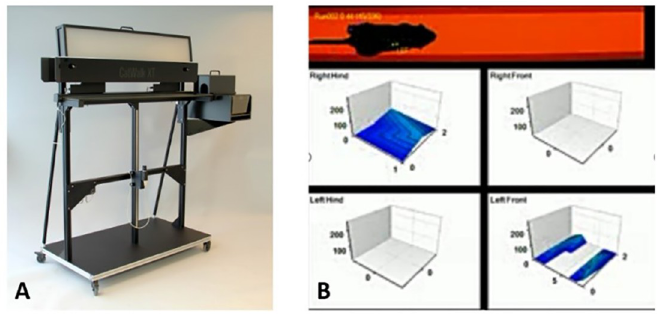
Fig 1. Overview of the CatWalkXT 1 automated gait analysis system. The hood is elevated to obtain a better overall impression of the walkway. For gait analysis, the hood is closed creating a tunnel guiding the animals direction of movement (A, image provided Noldus Information Technology, Wageningen, The Netherlands). Fruthermore, an example of automated CatWalkXT 1 footprint recognition is provided (B).